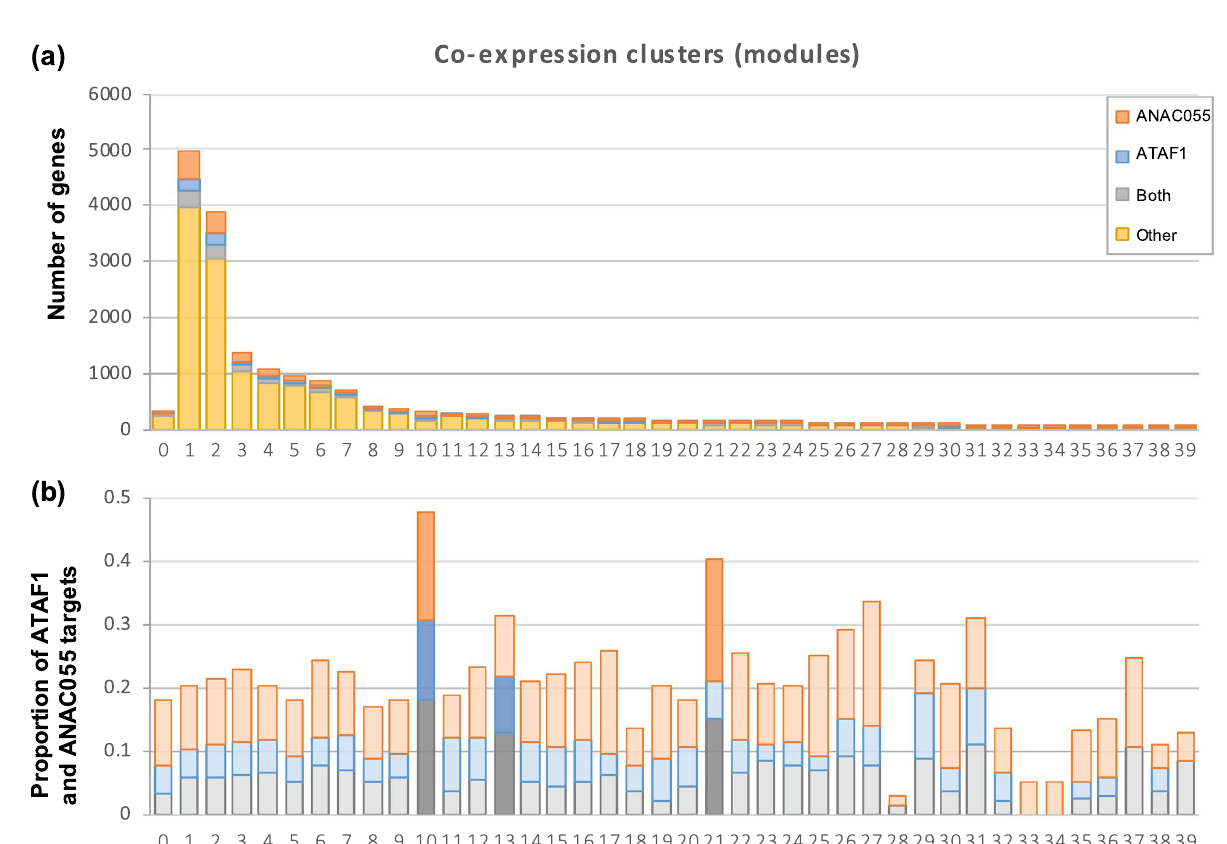
Figure 6. Potential targets of ATAF1 in response to heat stress. ( a ) The bar graph shows the number of genes in each co-expression cluster. A clustering analysis was performed by weighted gene correlation network analysis, which resulted in 40 clusters of genes co-expressed together. ( b ) The bar graph shows the proportion of ATAF1 and ANAC055 targets in each cluster, including genes targeted by both; clusters with significant enrichment of ATAF1 and ANAC055 target genes are shaded ( P < < 0.001); only two clusters (10 and 13) are highly enriched with ATAF1 targets; clusters 10 and 21 are significantly enriched for ANAC055, and clusters 10, 13 and 21 are enriched for genes that are targeted by both transcription